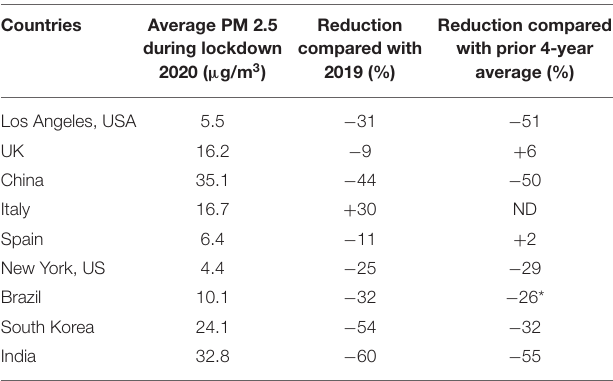
( Table 1 ). According to Fei Liu, an air-quality scientist at NASA’s Goddard Space Flight Center, such dramatic dropoff in the air pollution was seen for the first time from January 2020. China